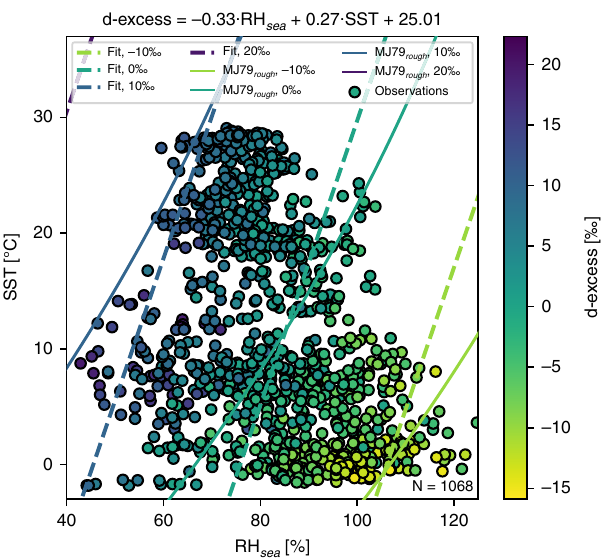
Fig. 3 Observed in fl uence of relative humidity (RH sea ) and sea surface temperature (SST) on deuterium excess (d-excess) in near-surface vapour compared with MJ79 theory. The scatters represent the observations in an SST/RH sea diagram, with colours indicating the d-excess values, for measurements at 6-h resolution during the period 29 June 2015 to 30 June 2017, considering only data without any potential in fl uence of land- or sea ice-based processes (see the Methods section for details on data fi ltering). The dashed lines correspond to constant d-excess values (of − 10 ‰ , 0 ‰ , 10 ‰ and 20 ‰ from green to purple lines) calculated from the empirical estimate of d-excess as a function of SST and RH sea (Eq. (1); see text for details). The solid lines correspond to constant d-excess values (of − 10 ‰ , 0 ‰ , 10 ‰ and 20 ‰ from green to purple lines) calculated with the MJ79 model, for kinetic fractionation coef fi cients of a rough regime and the VSMOW-SLAP reference as the isotopic composition of the